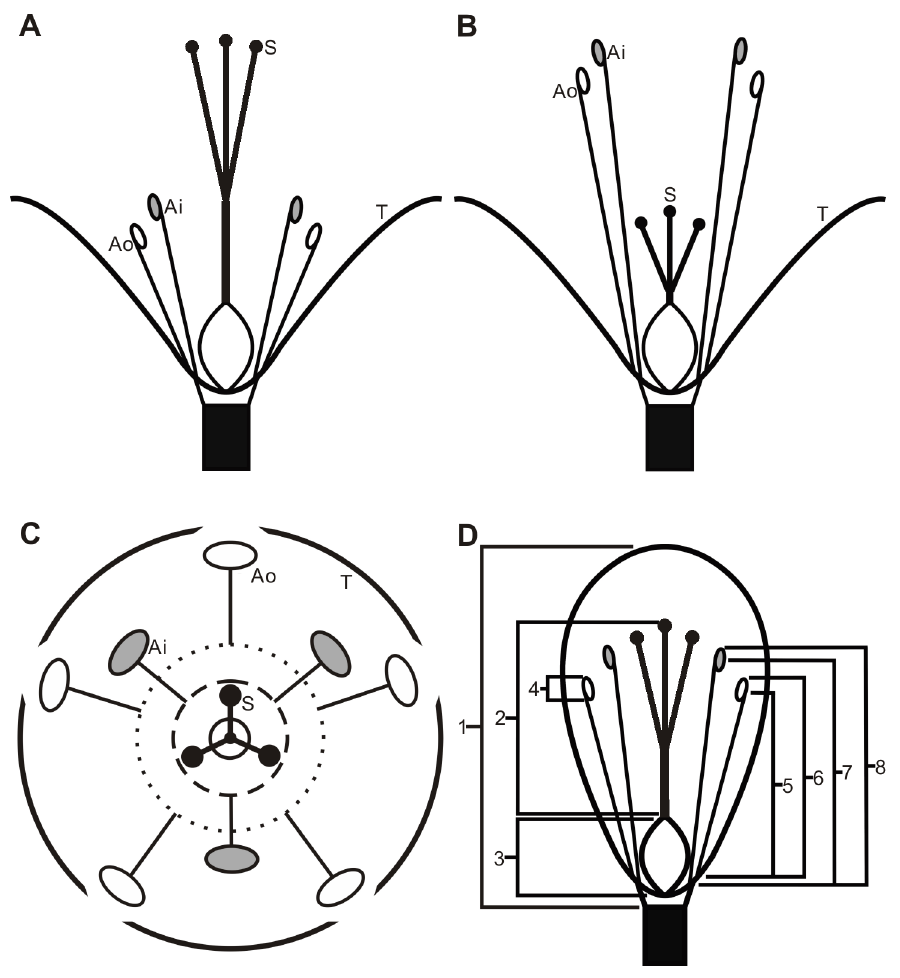
Figure 1. The structure of flower and floral organ measurements in Polygonumjucundum . A, the longitudinal section of the long-styled flower; B, the longitudinal section of the short-styled flower; C. the cross section of the flower; D, floral organ measurements: (1) bud length, (2) style length, (3) ovary length, (4) anther length, (5) outer filament length, (6) outer anther height, (7) inner filament length, (8) inner anther height. Ai, inner anther; Ao, outer anther; S, stigma; T,